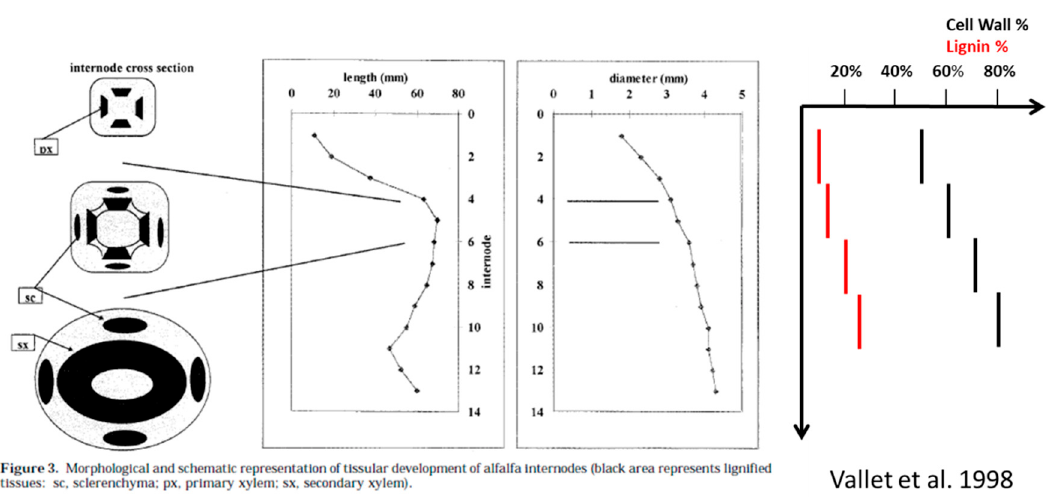
Figure 11. Progression of stem internode length and diameter from top to bottom stems of alfalfa associated with the secondary cell wall and lignin deposition. Data obtained at Lusignan (46.46° N; 0.07° E), France, and graphs were redrawn from Vallet et al. [43].